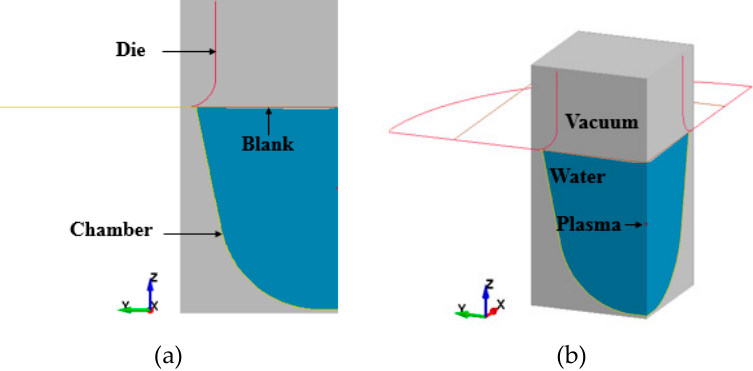
Figure 5. ( a ) Y-Z plane view and ( b ) three-dimensional view for numerical simulation model of electrohydraulic forming process.